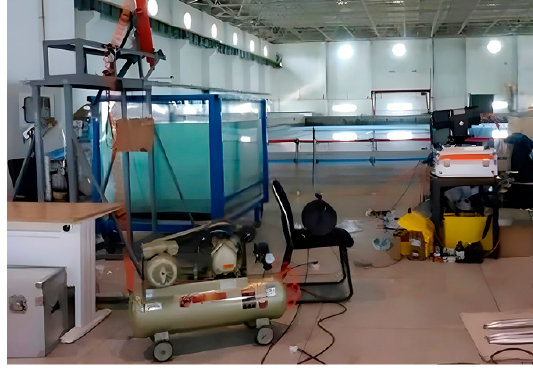
Figure 2. Overall view of the experimental device.